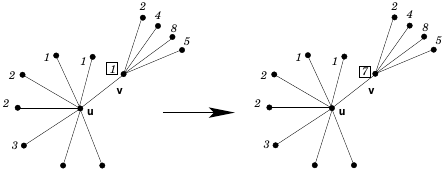
Fig. 1: A way to modify an instance I not satisfying P I ( u